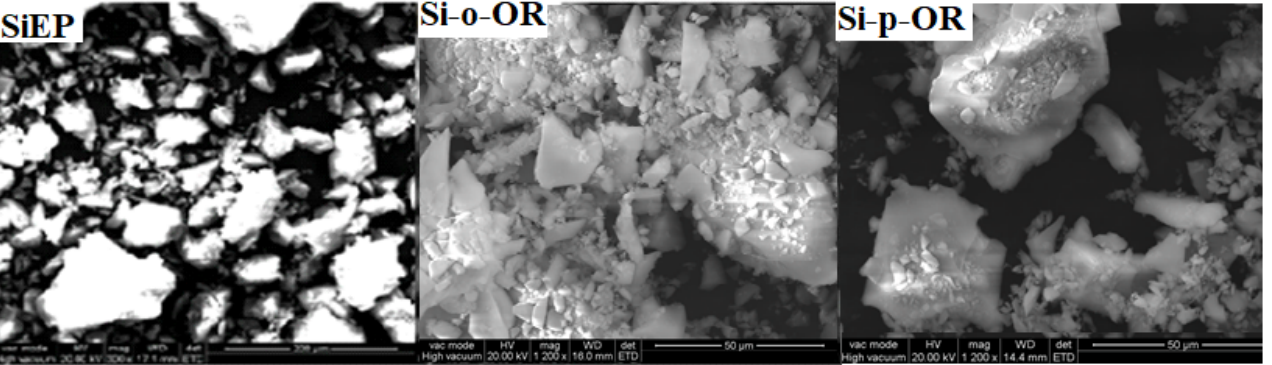
Figure 2. SEM images of Si-EP, Si-o-OR and Si-p-OR materials. Thermogravimetric analyses of SiEP, Si-o-OR and Si-p-OR were undertaken (Figure 3). SiEP show a mass loss of 10.8% between 200 and 800 °C, which corresponds to the decomposition of the silanol groups bound to the surface. For Si-o-OR and Si-p-OR , two decomposition steps are observed. The first one presents a weight loss of 3.98% for Si-p-OR and 4.25% for Si-o-OR , which starts in the range of 25–100 °C and which mainly corresponds to water loss. The second step shows a mass loss of 12.91% and 13.42% for the two hybrid materials, respectively, which can be ascribed to the decomposition of the (furan-2-ylmethyleneamino) phenol ligand.